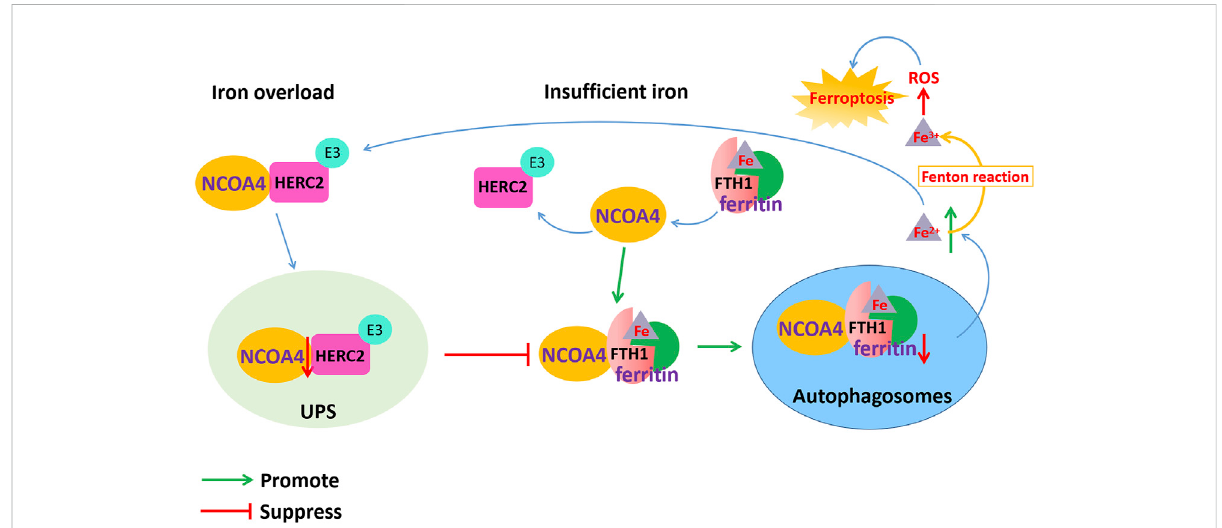
FIGURE 3 Dysfunction of NCOA4-mediated ferritinophagy induced ferroptosis in AD. NCOA4 can release free iron by the autophagic degradation of ferritin.Whencellularironisoverloaded,thebindingofNCOA4andHERC2isenhanced.HERC2mediatesthedegradationofNCOA4inanubiquitin- dependent manner, thereby suppressing the binding of NCOA4 and ferritin and inhibiting the release of iron and ferritin degradation by ferritinophagy. When cellular iron is insuf fi cient, ferritin-containing iron combines with NCOA4 to form a complex through FTH1 subunit of ferritin, which mediates iron release from ferritin storage through the ferritinophagy pathway. However, the excessive Fe 2+ content in cells transforms Fe 2+ into Fe 3+ through the Fenton reaction to generate ROS, which causes lipid peroxidation and oxidative stress and ultimately leads to